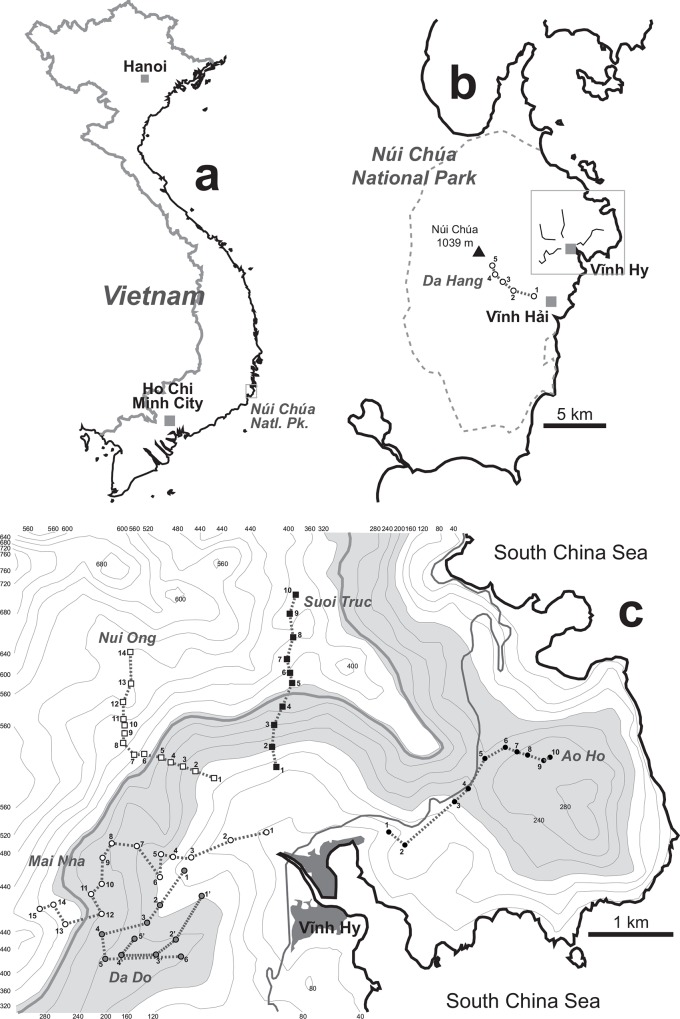
Sampling of Chrysomelidae in the Núi Chúa National Park.(a) Geographic location of the study site in southern Vietnam and (b) placement and general sampling design in the Núi Chúa National Park. (c) Forest paths sampled from Vinh Hy and into higher elevations across the putative ecotone (gray area) between seasonally dry tropical forest in coastal lowlands and moister forest types. A thick gray line marks a pragmatic boundary between biome types putatively representing the strongest structuring effect of the ecotone (see main text for details).